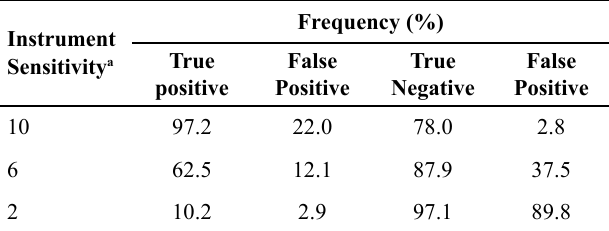
Table 2. Reliability of Termatrac™ detection of C. brevis as determined by frequencies of true and false readings for termite infested boards.